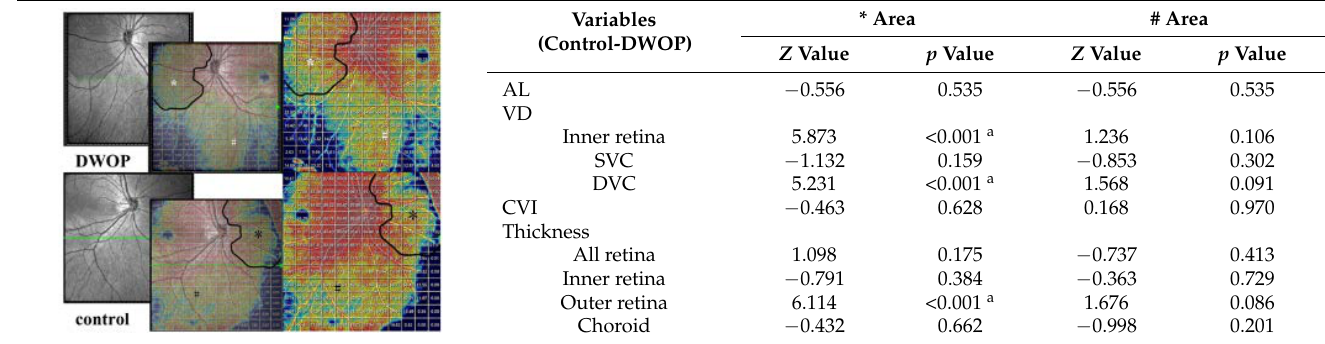
Table 3. Quantitative analysis of different regions in paired eyes using SS-OCTA.